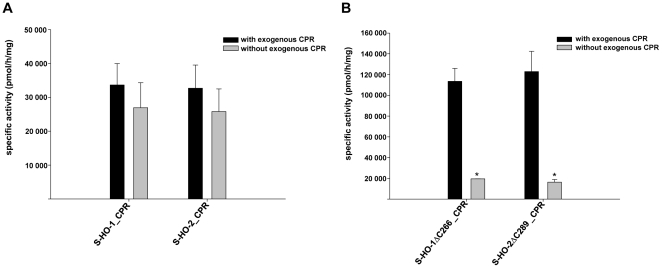
Specific enzyme activity assay of HO-CPR co-infections after purification.Measurements were made in the presence (black columns) and absence (grey columns) of exogenous CPR. (A) Co-purifications of full-length Strep-tagged HO-1 and HO-2 (B) Carboxy- terminally deleted HO isoforms. Data are shown as means ± SEM (n = 3, p<0.05).